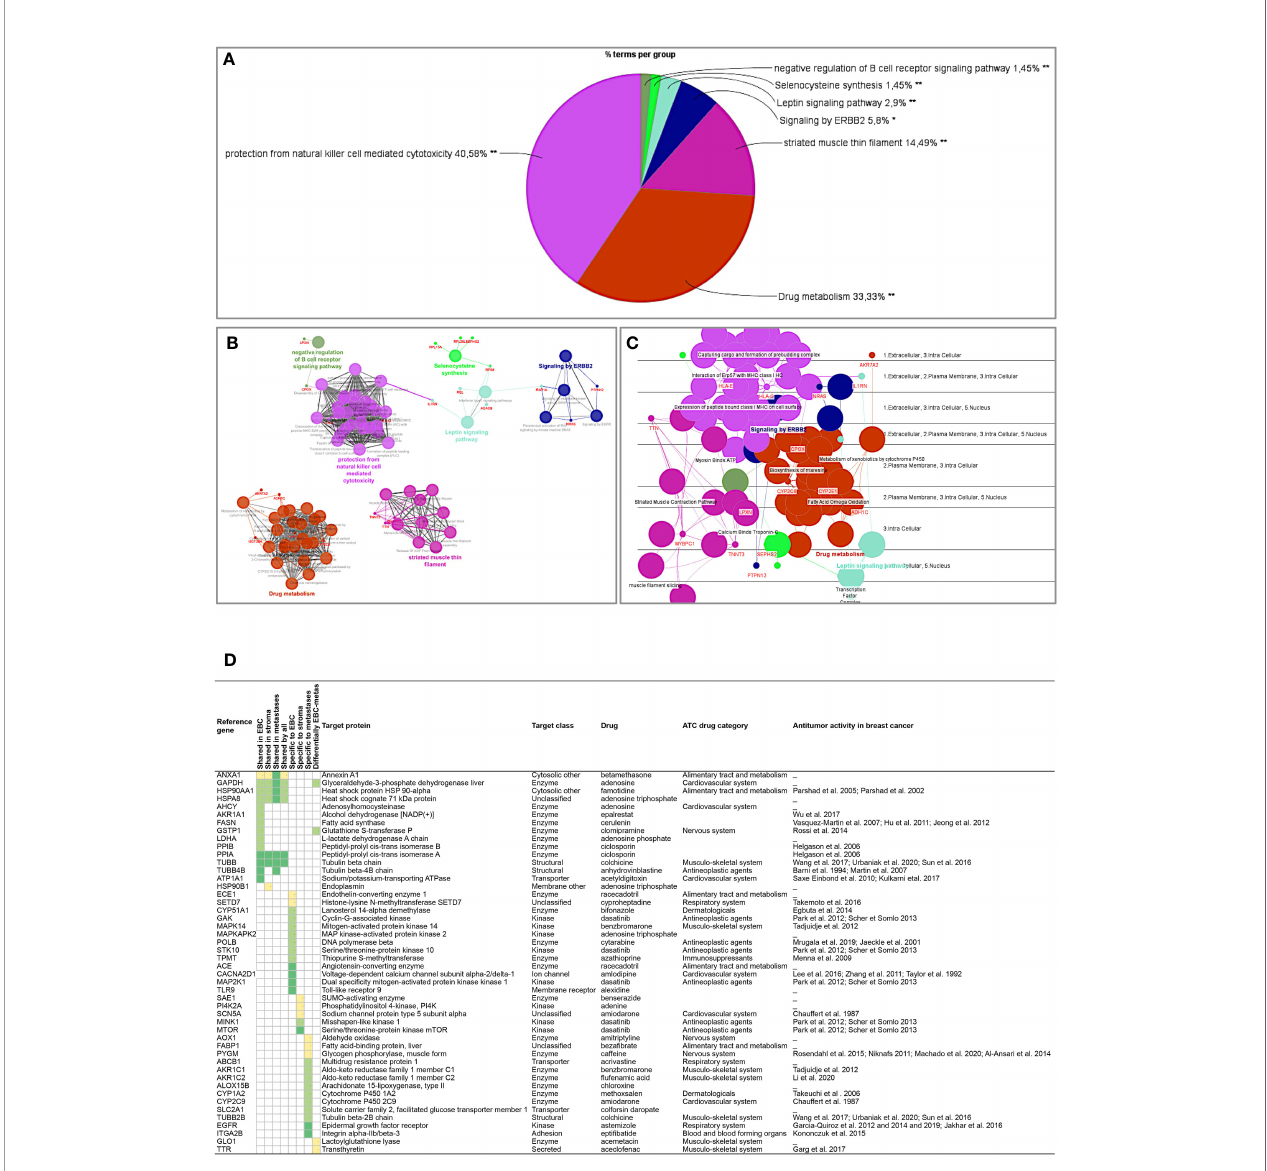
FIGURE 8 | Analyses of the proteins from the clonal proteome associated both with DMFS and OS, showing (A) enrichment, (B) networks analysis, (C) cerebral layout of cellular distribution, and (D) their druggability. In the table, targets with a known drug-target interaction are in dark green, those with a less known interaction are in green, and those with limited data are in yellow. The target class, matching drug name, ATC classi fi cation and reported antitumor activity in breast cancer are indicated. *p < 0.05; **p <